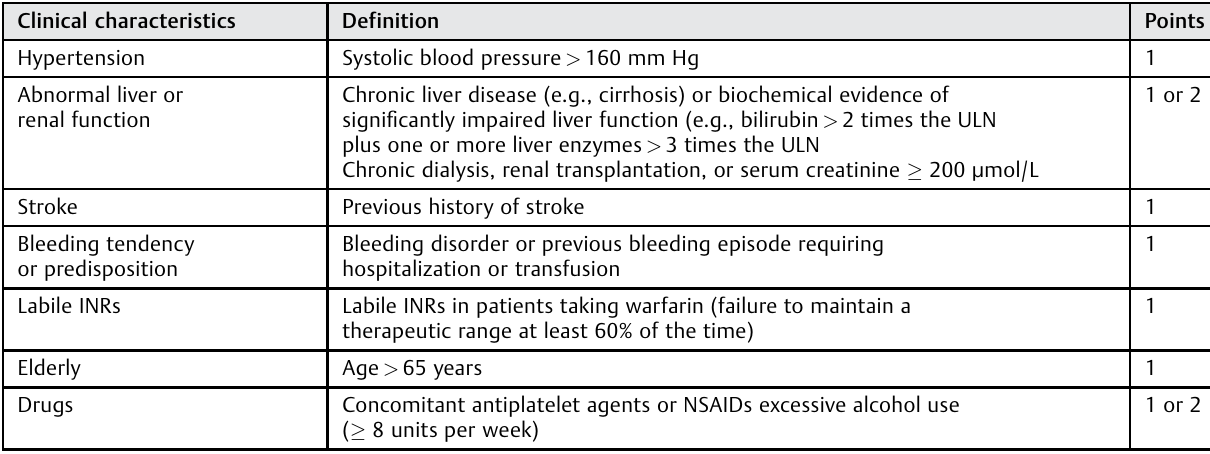
Table 3 Items of HAS-BLED 56,57 bleeding risk